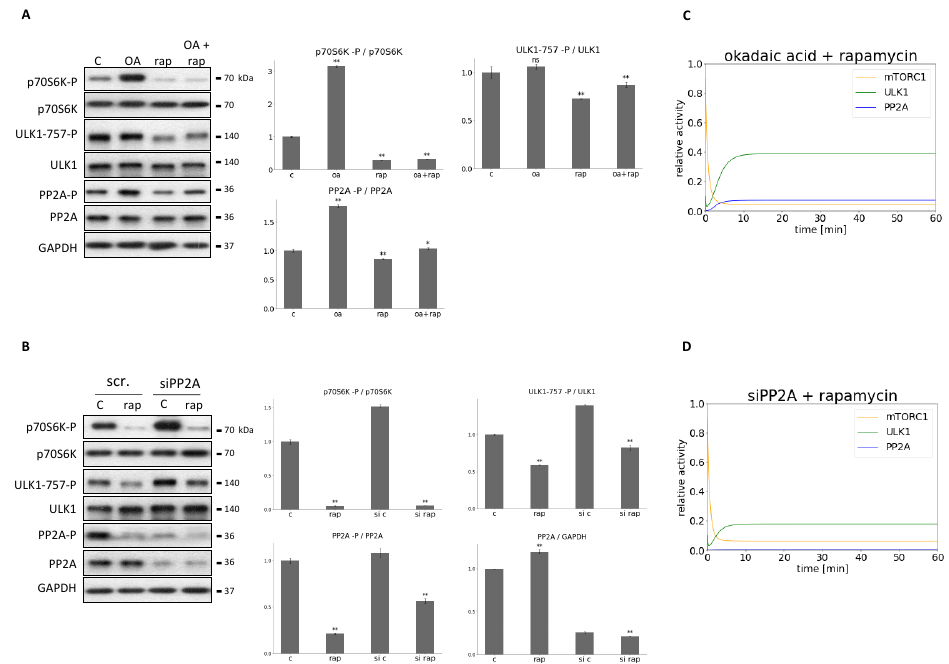
status of Ser-757 residue of ULK1) and PP2A (phosphorylation status of PP2A) were detected by immunoblotting during end of treatments (Figure 6).